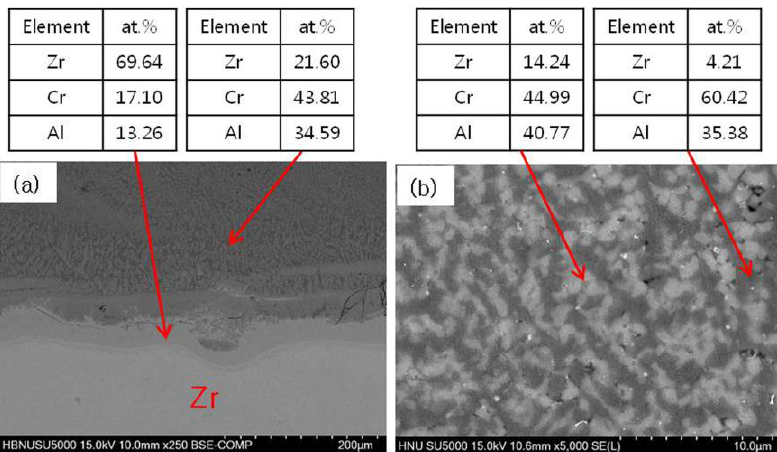
Figure 2. SEM-EDS (scanning electron microscopy–energy dispersive X-ray spectrometry) analysis results of CrAl laser-coated Zircaloy-4 substrate alloy: ( a ) near the Zr substrate; ( b ) Cr-rich coating layer.